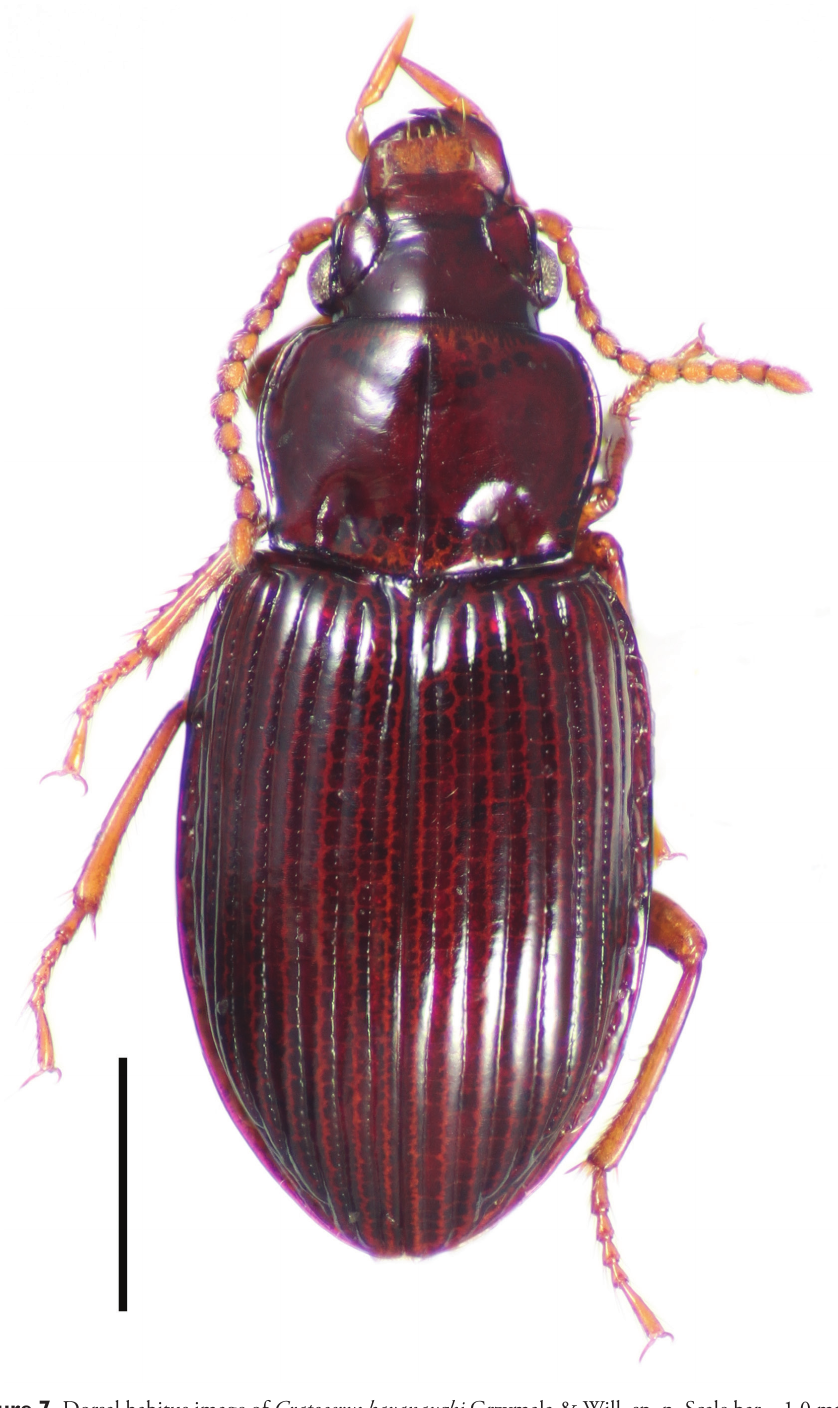
Figure 7. Dorsal habitus image of Cratocerus kavanaughi Grzymala & Will, sp. n. Scale bar = 1.0